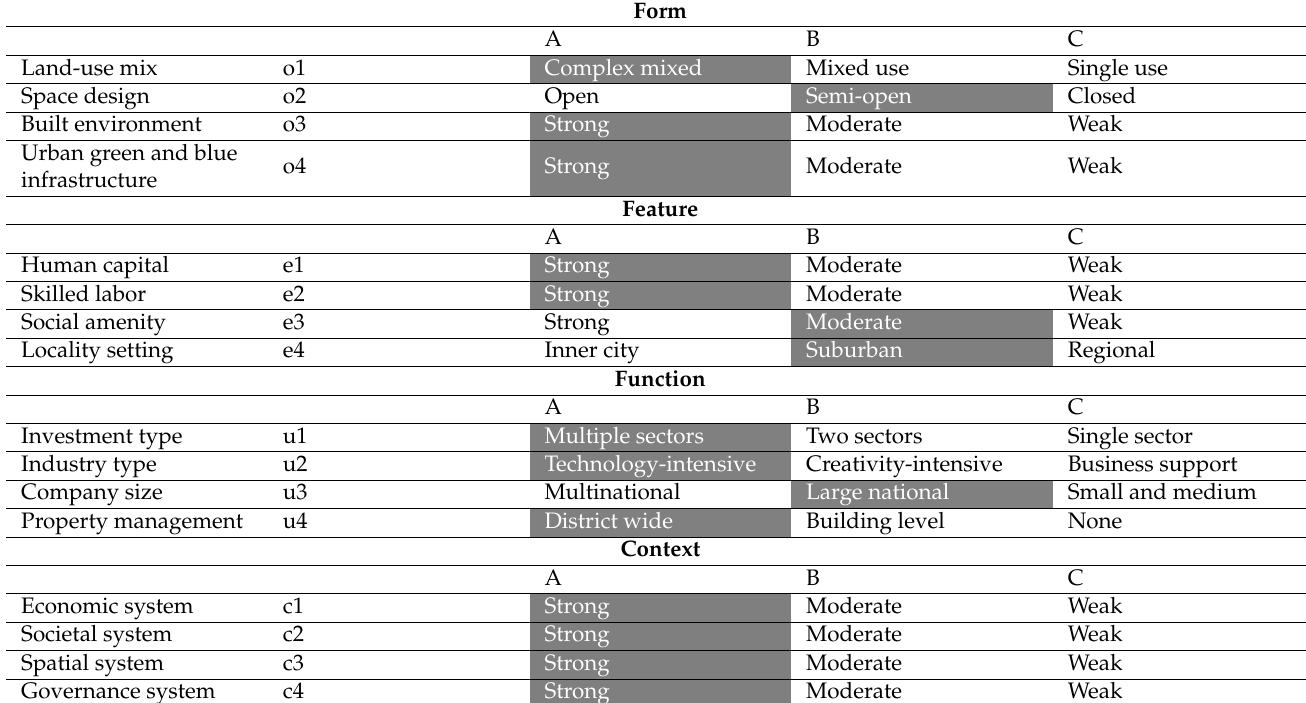
Table 3. An exemplar case study matrix of